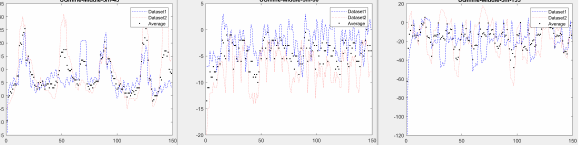
Figure 8 . Results of the tests at the middle of tunnel in